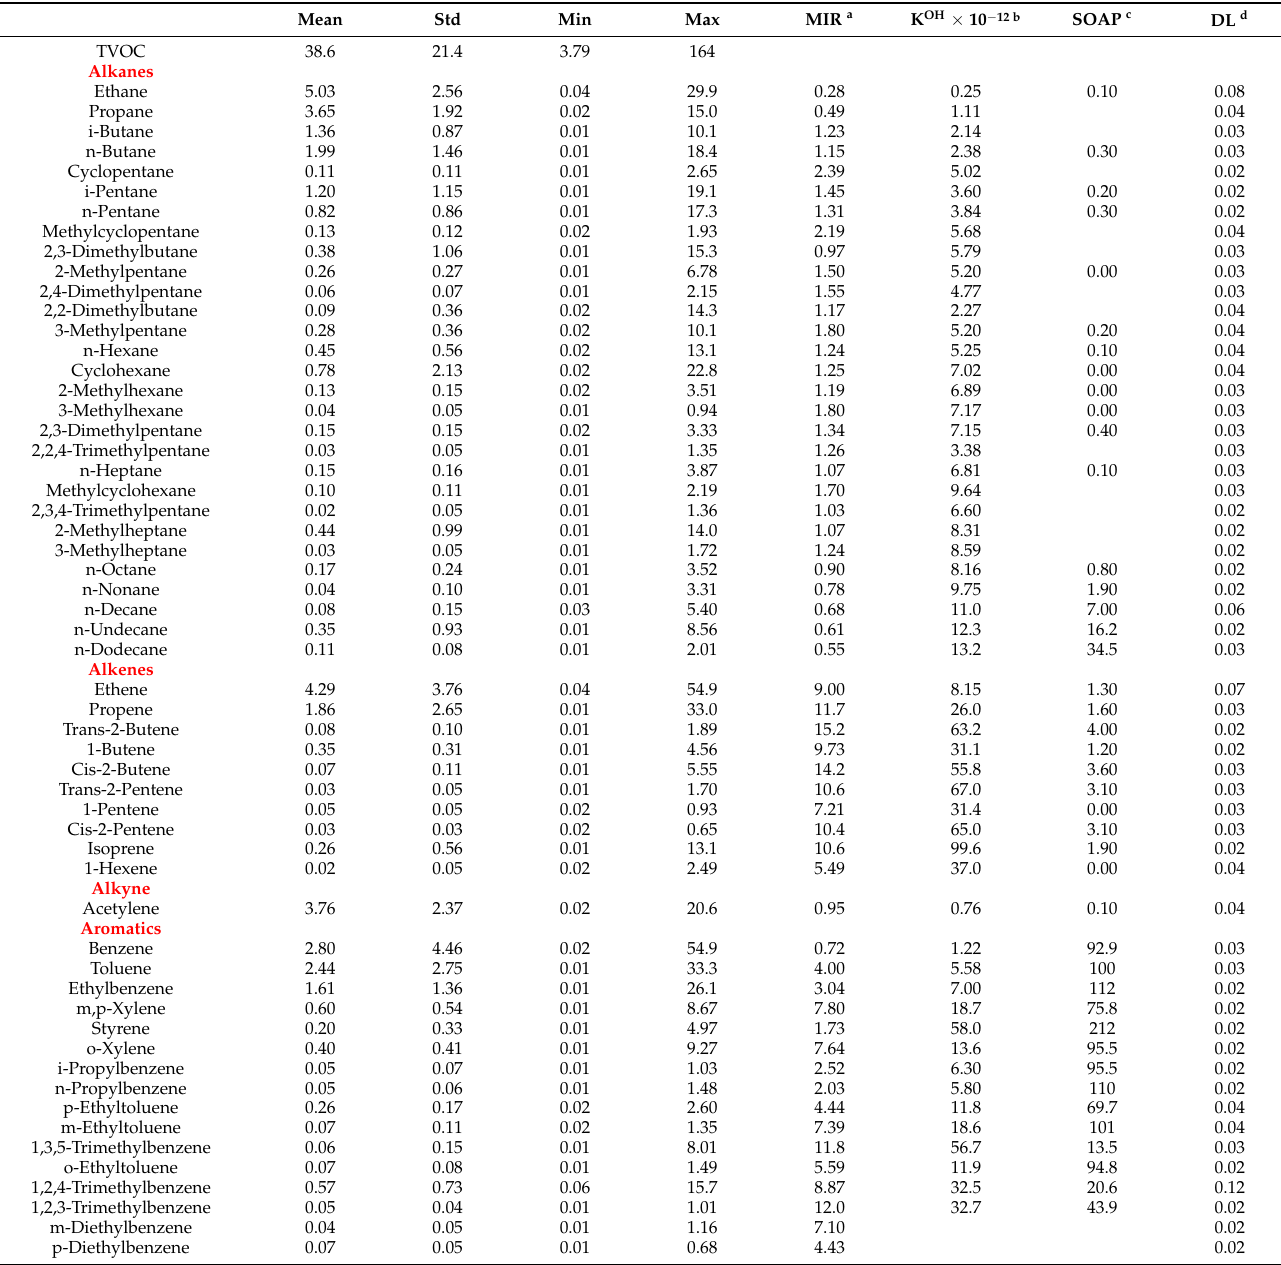
Table 2. The mean values of the VOCs (unit: